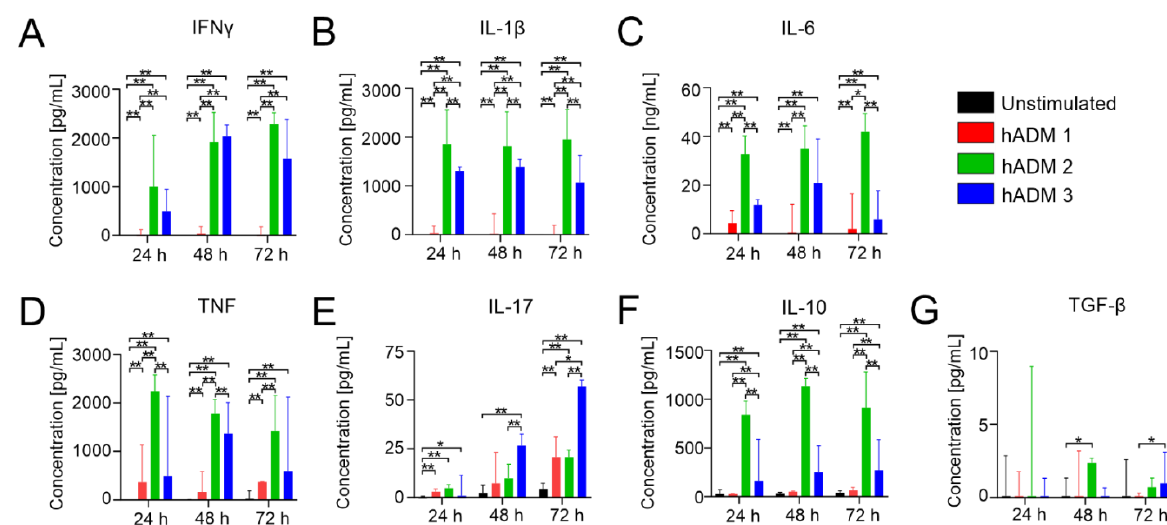
Figure 4. Method of hADM preparation induces differential cytokine secretion in vitro . Healthy donor PBMCs were co-incubated alone or with hADMs for 1, 2, or 3 days. Supernatants were collected, and ELISA was performed on 100 uL fractions. ( A – E ) Pro-inflammatory and ( F , G ) Anti-inflammatory cytokine and growth factor concentrations. Results expressed as medians + interquartile range. Two-tailed Wilcoxon matched-pairs signed-rank test used for ( A – G ) n = 6 with 2 technical replicates. * p = 0.05, ** p = 0.01.